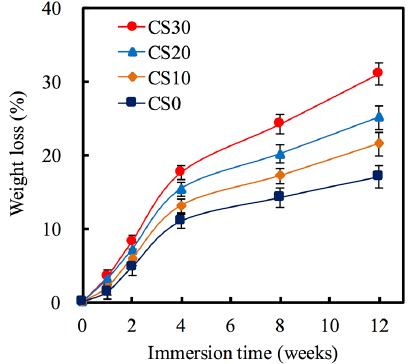
Figure 6. Weight loss of various scaffolds after immersion in SBF for predetermined time durations.